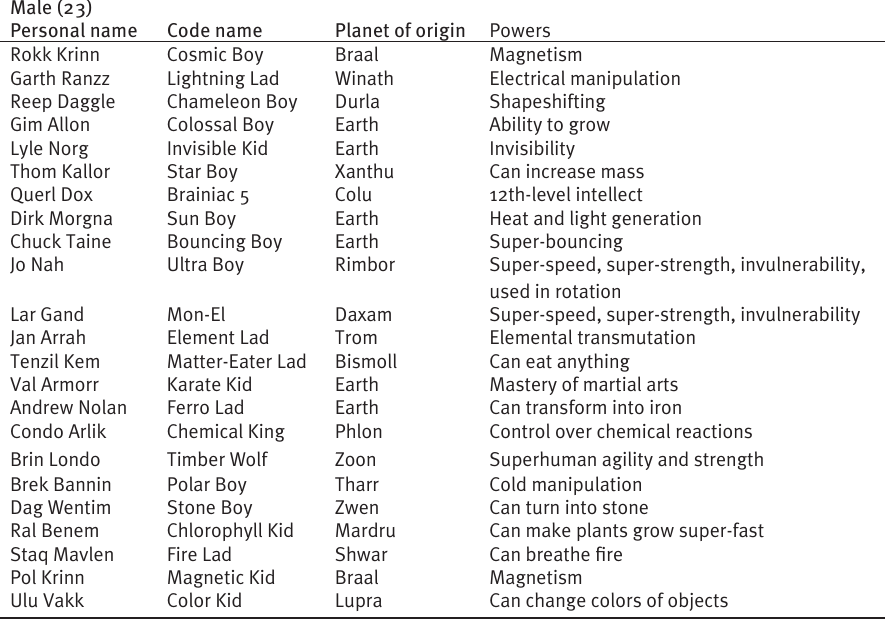
TABLE 1 MALE SILVER AGE MEMBERS OF THE LEGION OF SUPER-HEROES